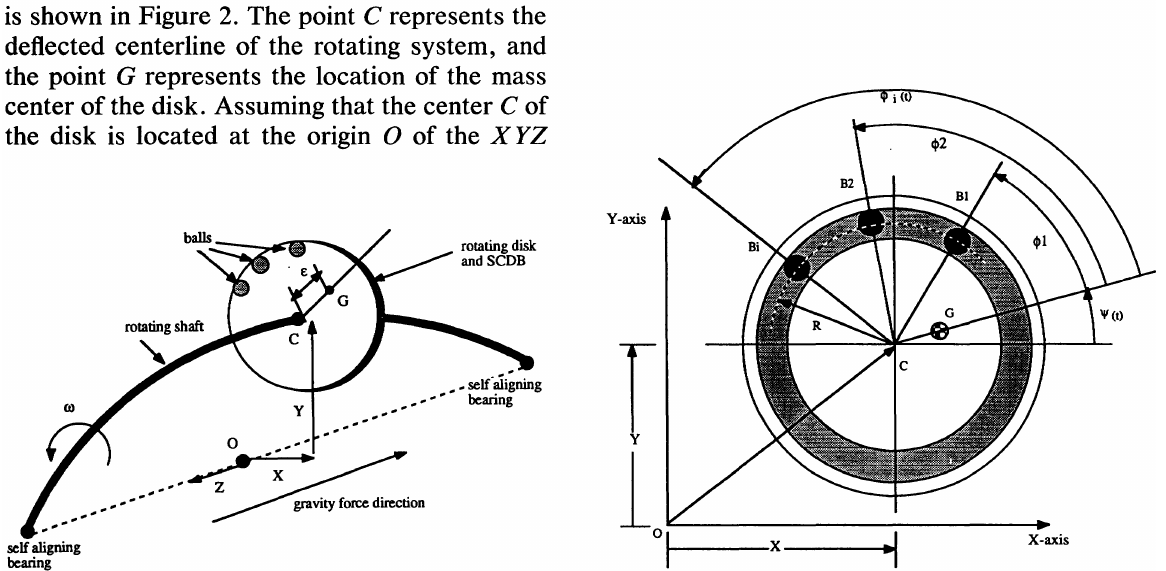
FIGURE 1 Rotating system of the SCDB. FIGURE 2 Self-compensating dynamic